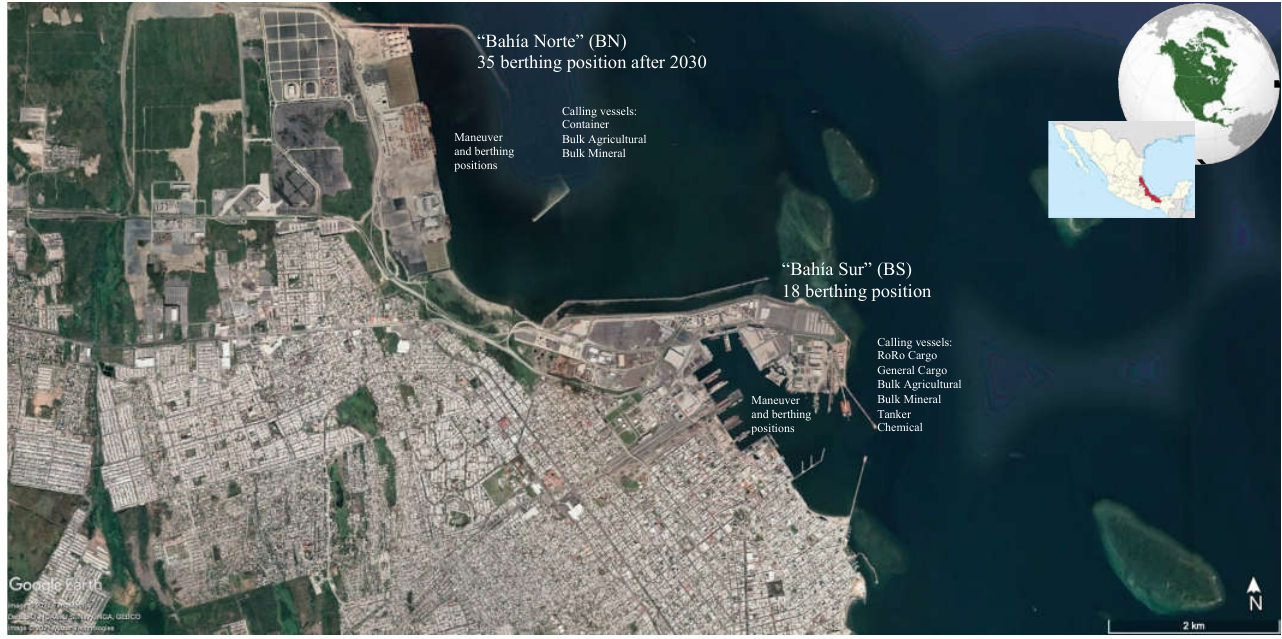
Figure 1. The port of Veracruz.